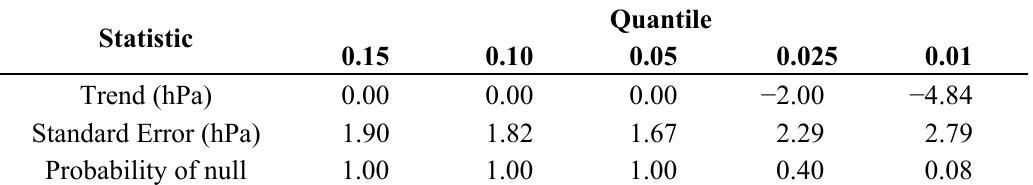
Table 4. Summary statistics for quantile regression, all data versus